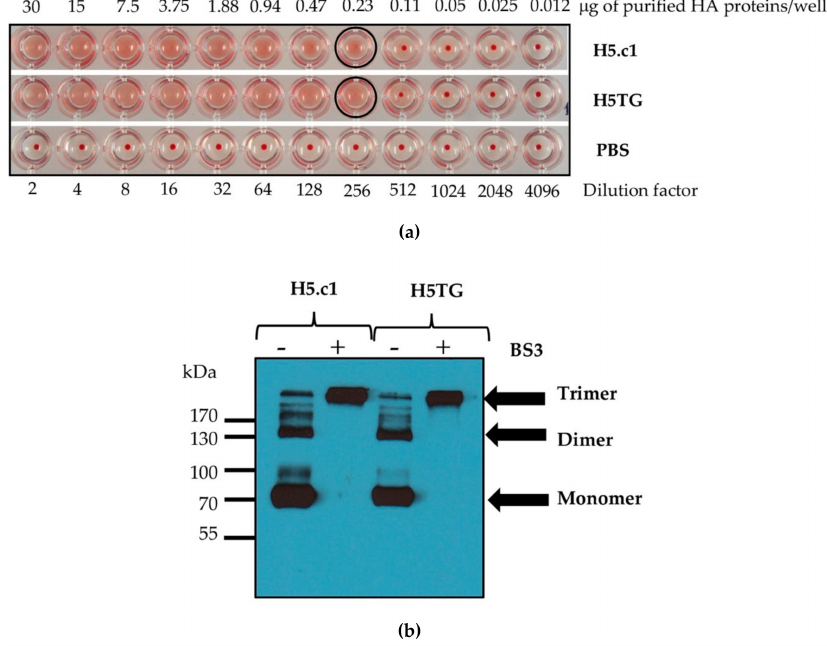
Figure 4. Functional characterization of the immobilized metal ion a ffi nity chromatography (IMAC)-purified haemagglutinin (HA) proteins ( a ); structural characterization of the IMAC-purified HA proteins by a cross-linking reaction using bis[sulfosuccinimidyl suberate (BS3) ( b